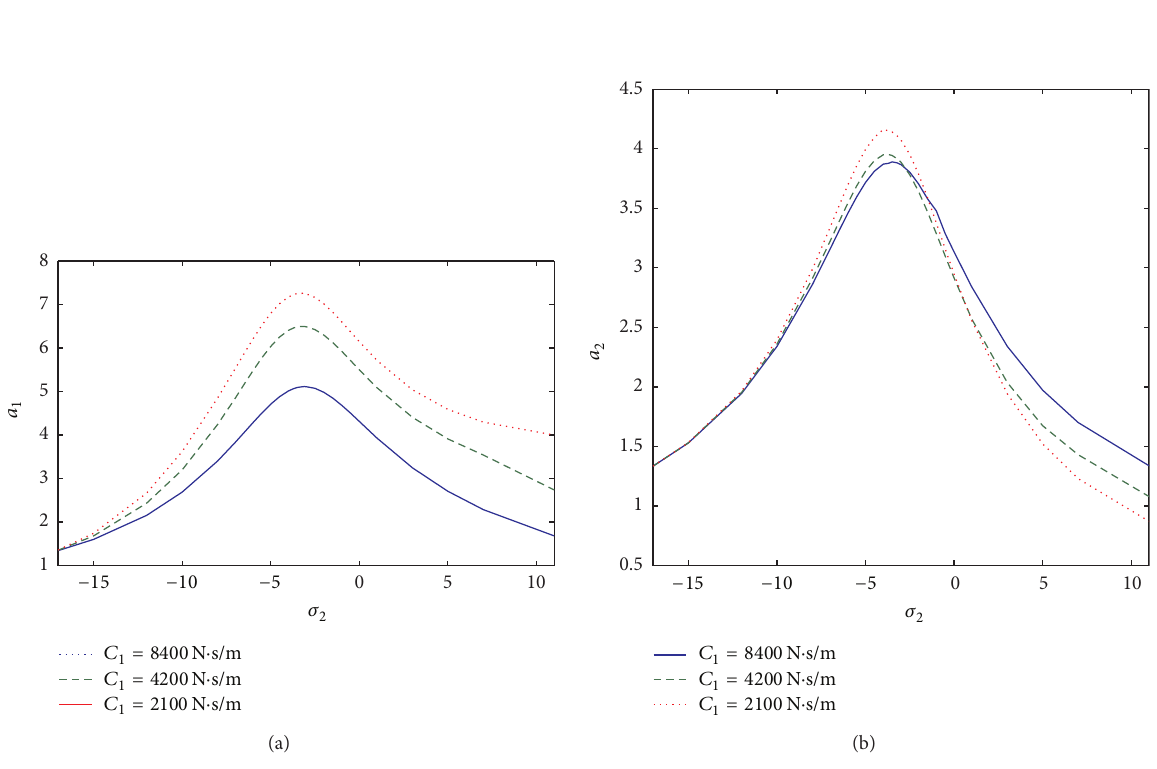
Figure 7: The influence of zero stiffness damper’s